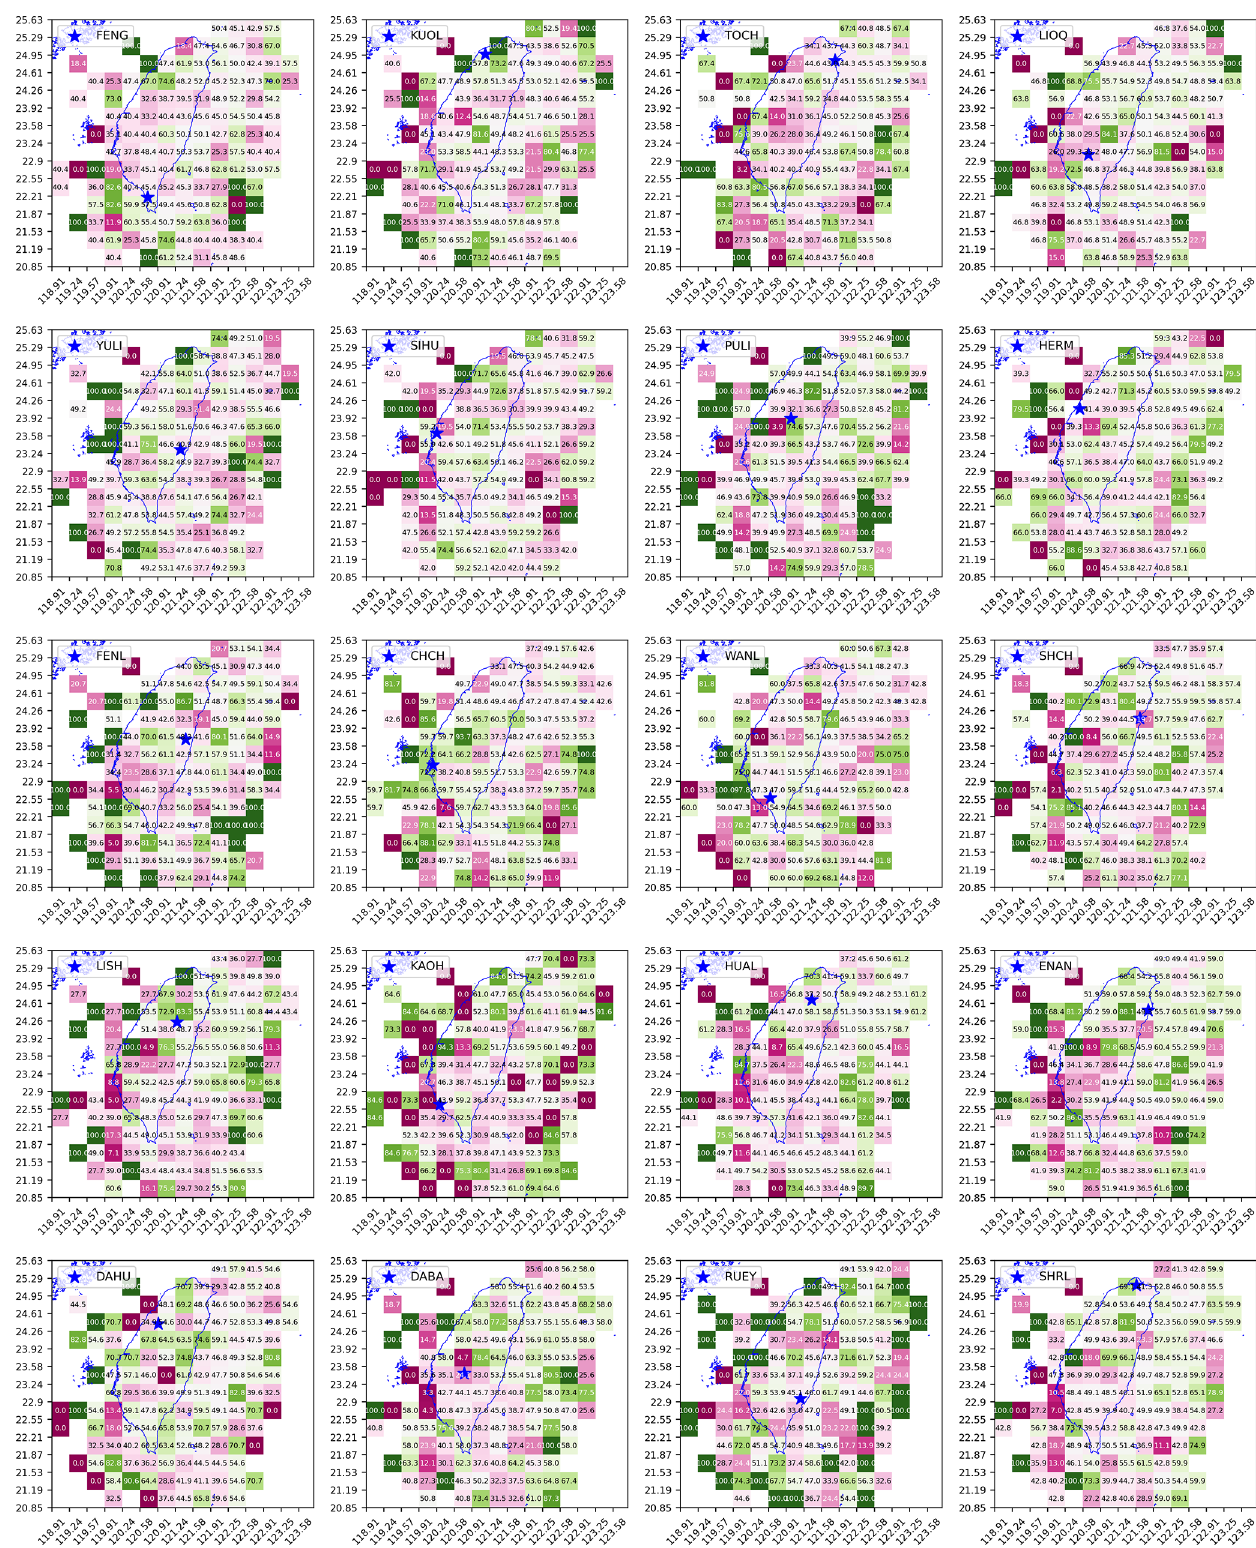
Figure 8. The grid maps of EQ frequency ratio R F ( × 0 . 01 ) for 20 stations (obtained using optimal hyperparameters individually specified for each station in Fig.